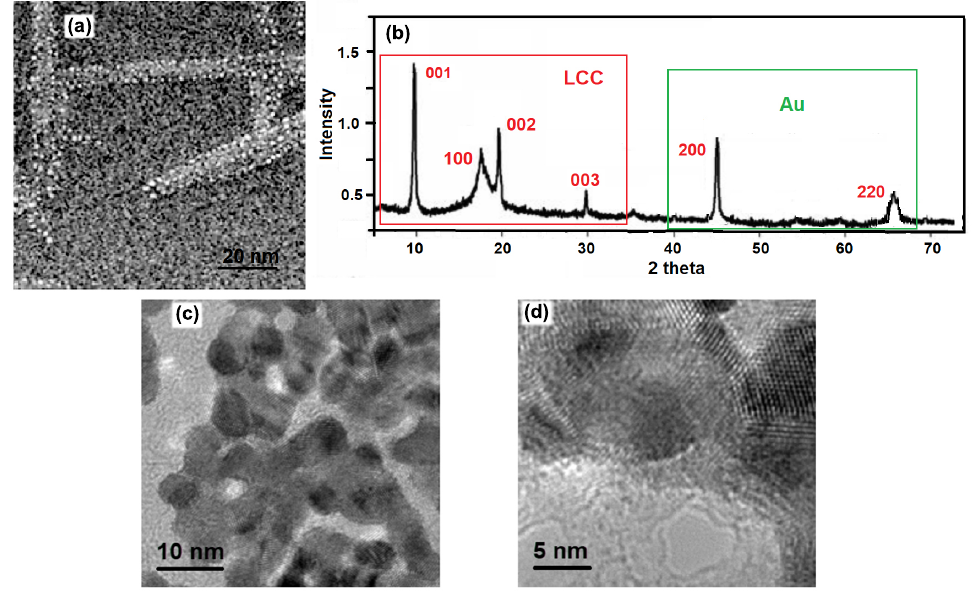
Figure 5. SEM image ( a ), corresponding XRD spectrum ( b ) and STEM images acquired in different points of Au@LCCs sample ( c , d ) with 1:2.9 ratio.